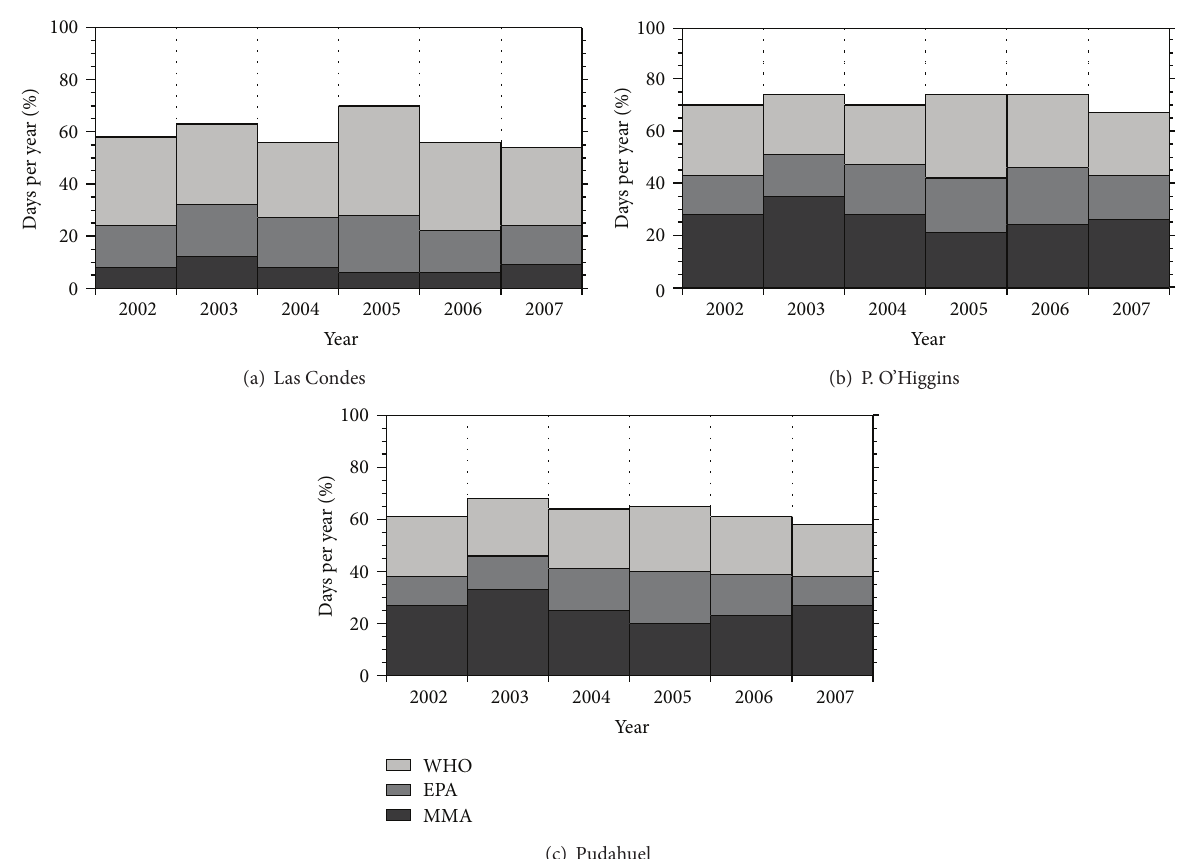
Figure 6: Percentage of days per year from 2002 to 2007 in which the concentration was greater than the threshold of the World Health Organization (WHO), the United States Environmental Protection Agency (EPA), and the Chilean Ministry of the Environment (MMA) standards. Label of the stations in Figure 1. Las Condes: C Label, P. O’Higgins: O Label, and Pudahuel: P